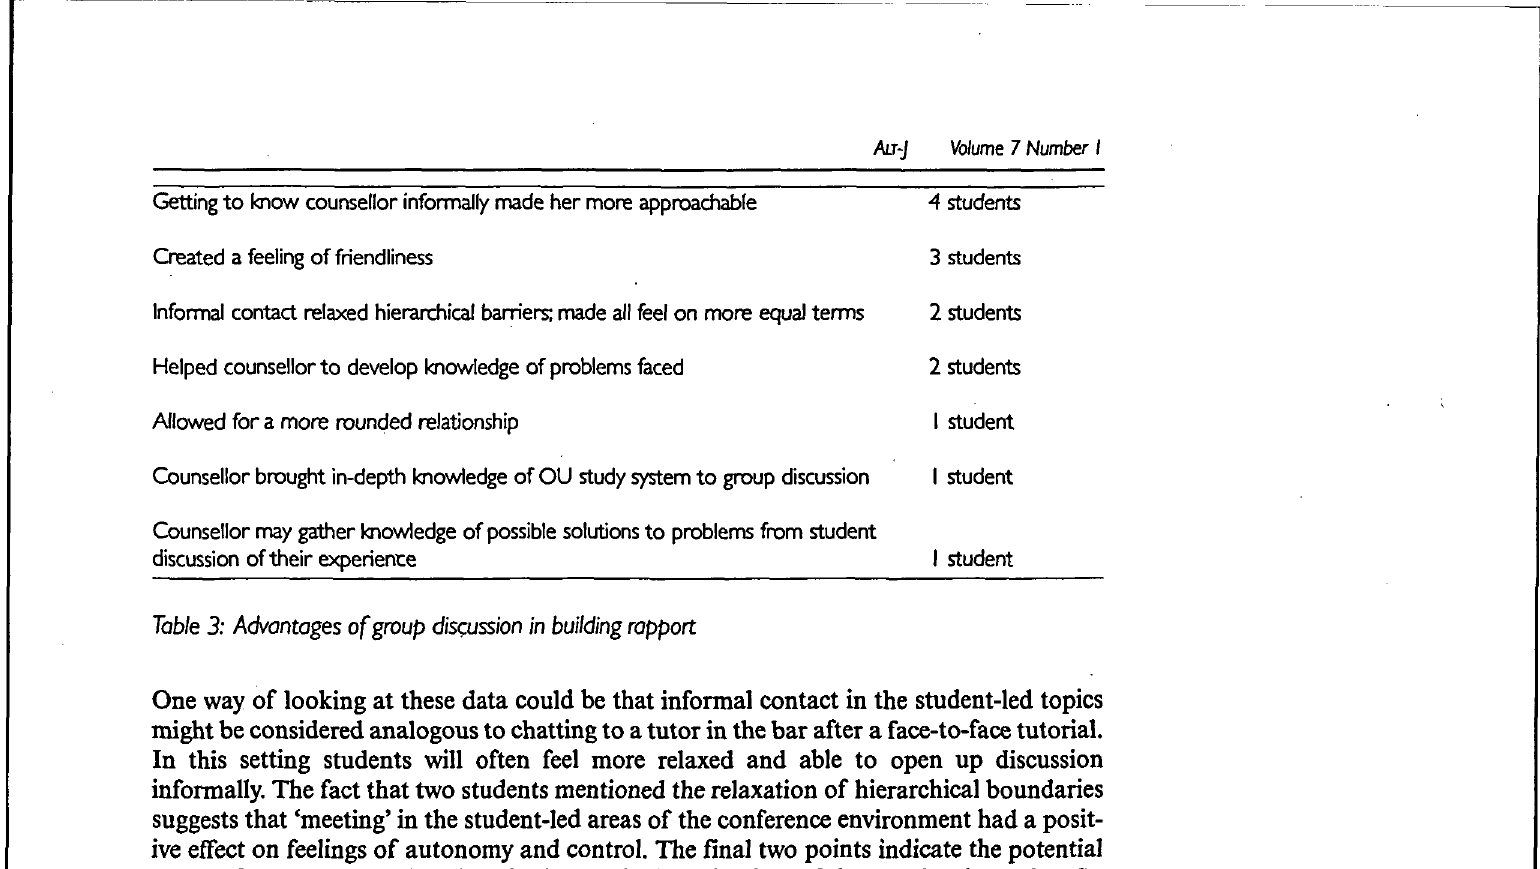
Table 3: Advantages of group discussion in building